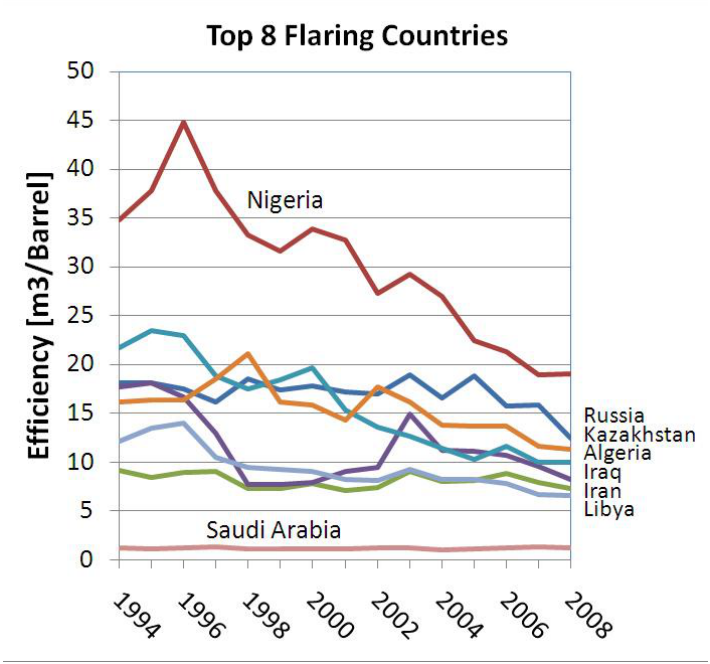
Figure 19. Gas flaring efficiency of the top eight flaring countries. Efficiency is defined as the volume of gas flared per barrel of crude oil produced. Nigeria is least efficient, but seems to be improving with time. Saudi Arabia consistently out performs the other top flaring countries implying that it is quite efficient in the utilization of associated